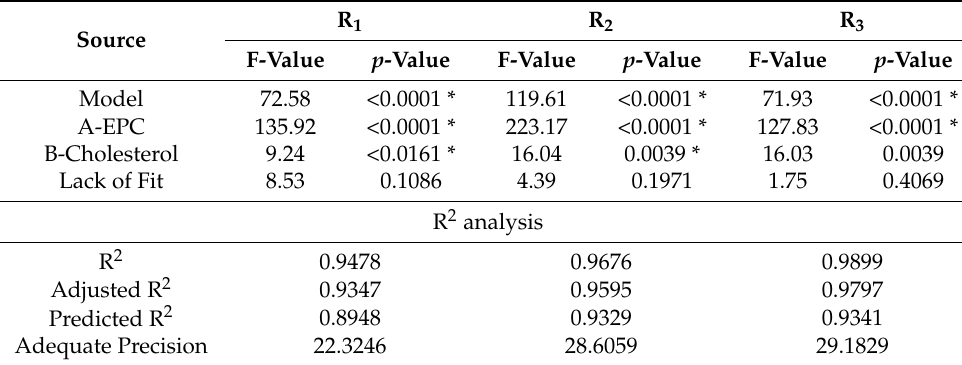
Table 2. Results of statistical analysis of all dependent variables R 1 , R 2 and R 3